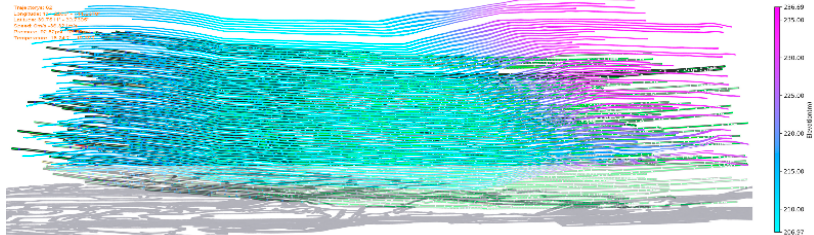
Figure 57. Elevation model with elevation ribbons superimposed on an attribute layer.